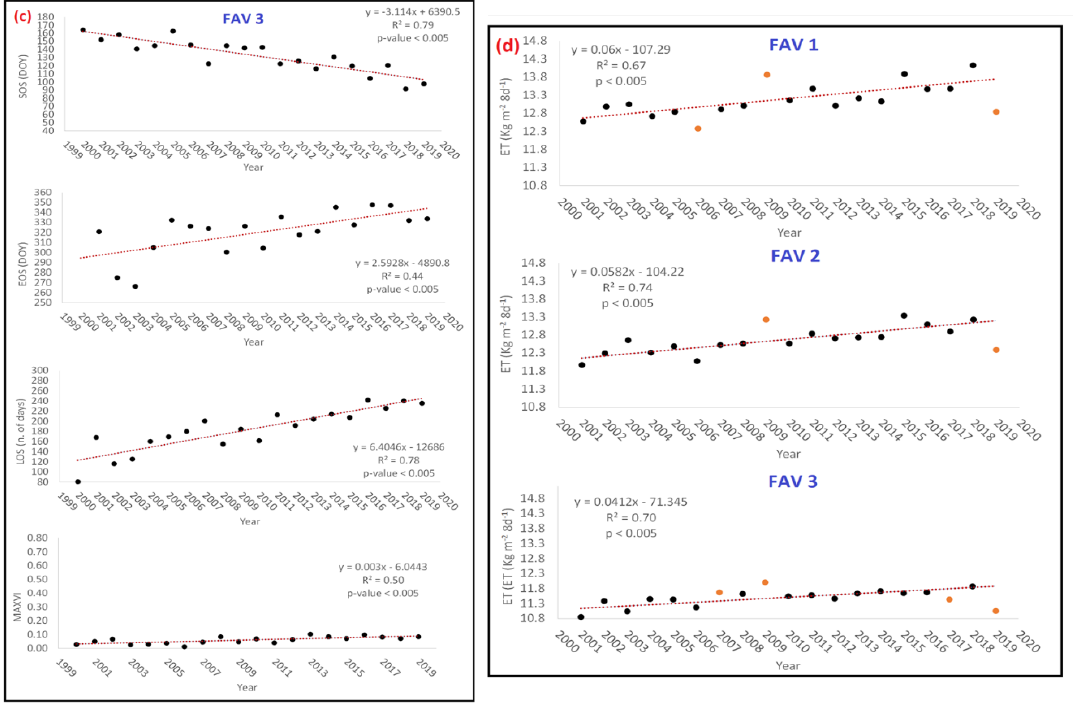
Figure 6. ( a – c ) Class average values of phenological metrics (PMs) (SOS, EOS, LOS, MAXVI) as estimated by TIMESAT 3.3 with Seasonal Trend decomposition by Loess (STL) for classes FAV1, FAV2, and FAV3. ( d ) Evapotranspiration (ET) average class values computed from ETS for classes FAV1, FAV2 and FAV3. Reported values correspond to the yearly mean value of the 8 days aggregated data from MOD16A2 product (for acronyms explanation, see Abbreviations). In all the graphs, the red-orange points represent outliers.